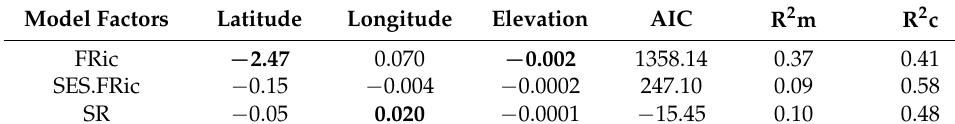
Table 2. Summary of the mixed linear models analyzing the effects of geographic gradients on the functional richness (FRic), standardized effect of the functional richness (SES.FRic), and (log- transformed) species richness [log(SR)]. The marginal (R 2 m) and conditional (R 2 c) coefficients of determination are presented. Values in bold indicate p values < 0.05.